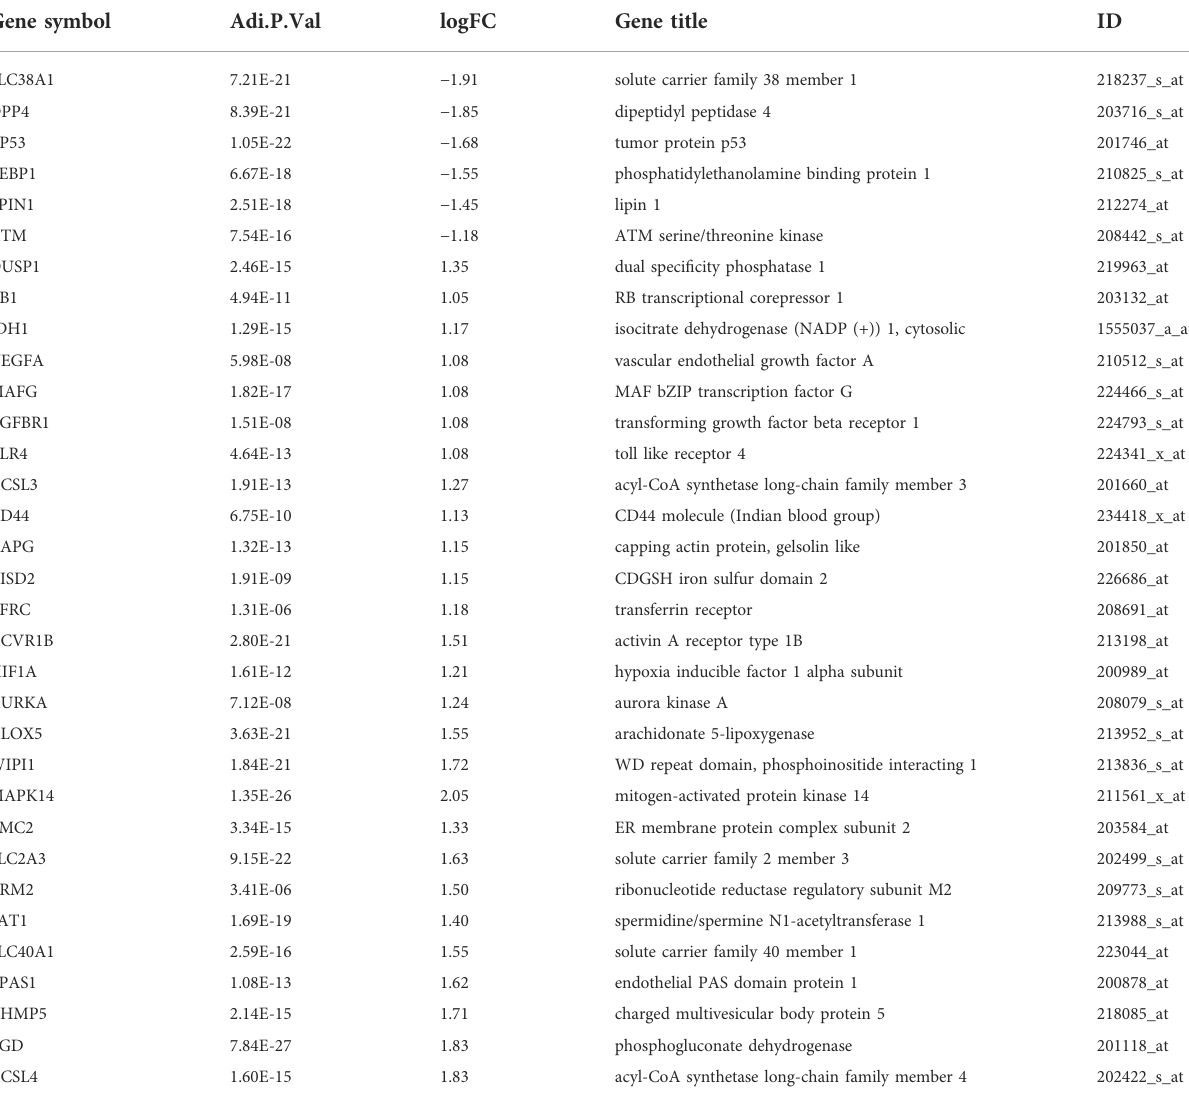
TABLE 1 Ferroptosis-related differentially expressed genes of